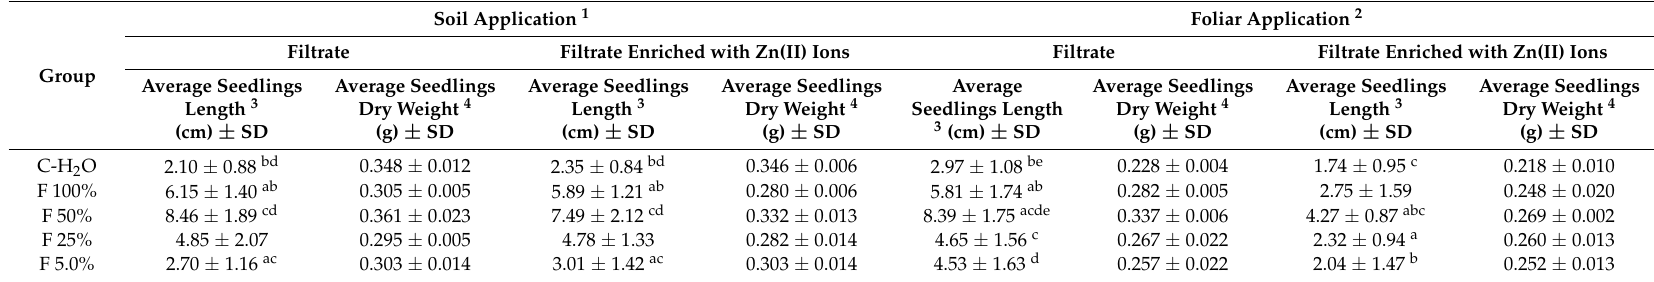
Table 2. The choice of the concentration of algal filtrate (F) for soil and foliar applications ( N =